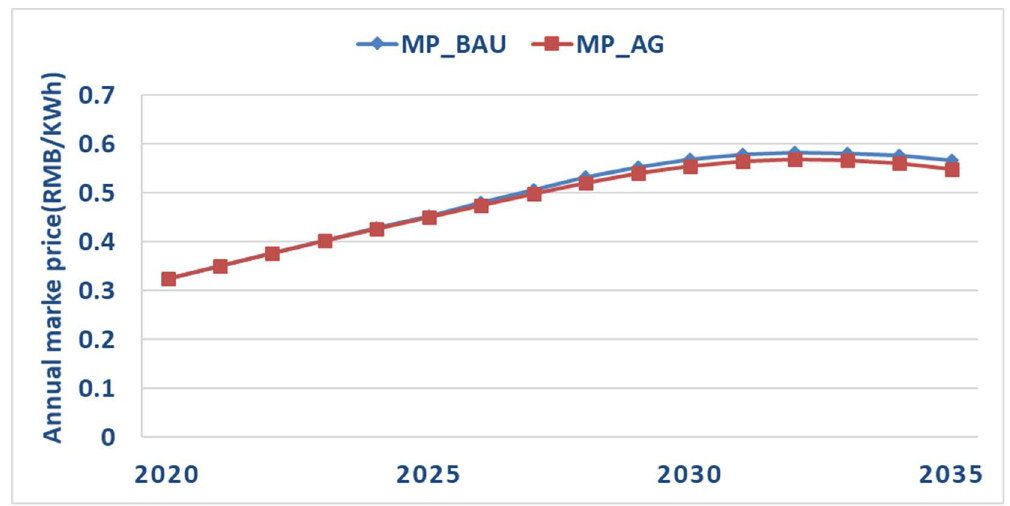
Figure 8. Comparison of the annual market price under the BAU and AG reserve capacity adjustment scenarios.